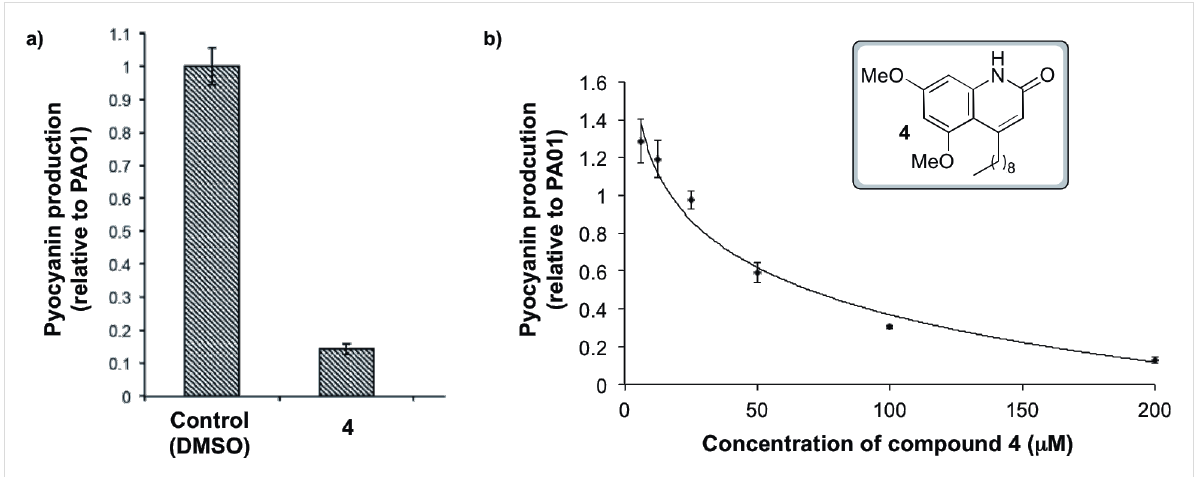
Figure 2: a) Inhibitory effect of compound 4 (200 μ M suspension in DMSO) on pyocyanin production in PAO1. DMSO was added as a control. No effect on growth was observed for the compound. b) Effect of various concentrations of 4 on pyocyanin production in PAO1. A logarithmic trend line has been fitted to the averaged data points (calculated using Microsoft ® Excel ® 2011). Growth conditions in both cases: cultures of PAO1 were grown in Luria broth medium in the presence of compound 4 (at the indicated concentration) with good aeration at 37 °C for 13 hours (initial OD 600 of 0.05 t = 0). After growth, pyocyanin production was quantified as previously described [29]. The data represents the averages and standard deviations from the results of three independent biological